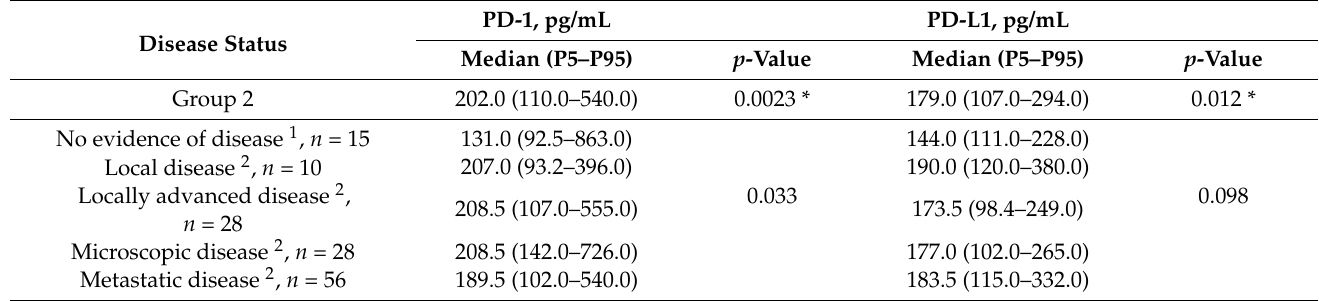
Table 2. Plasma PD-1 and PD-L1 concentrations stratified on the patients’ disease statuses.